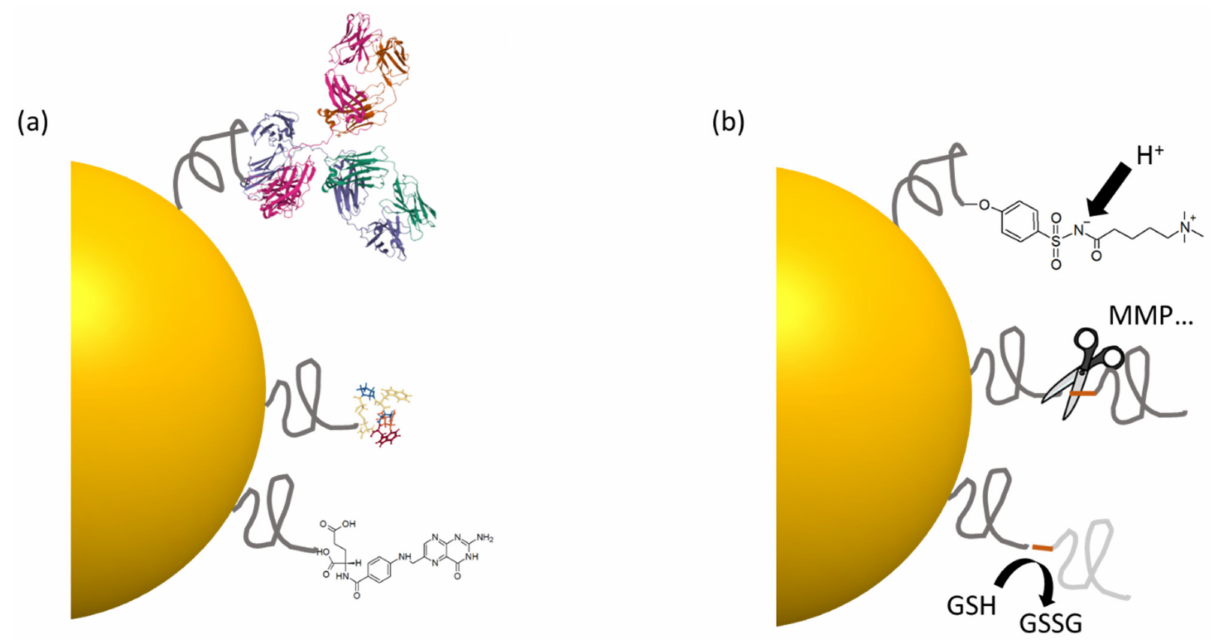
Figure 6. Strategies used for tumor targeting. ( a ) Active biomolecular targeting using antibodies, peptides such as RGD, or small molecules such as folic acid. ( b ) TME targeting, using acidic pH with protonable surface moieties, activity of overexpressed enzymes such as MMPs, or reduction from GSH to cleave surface